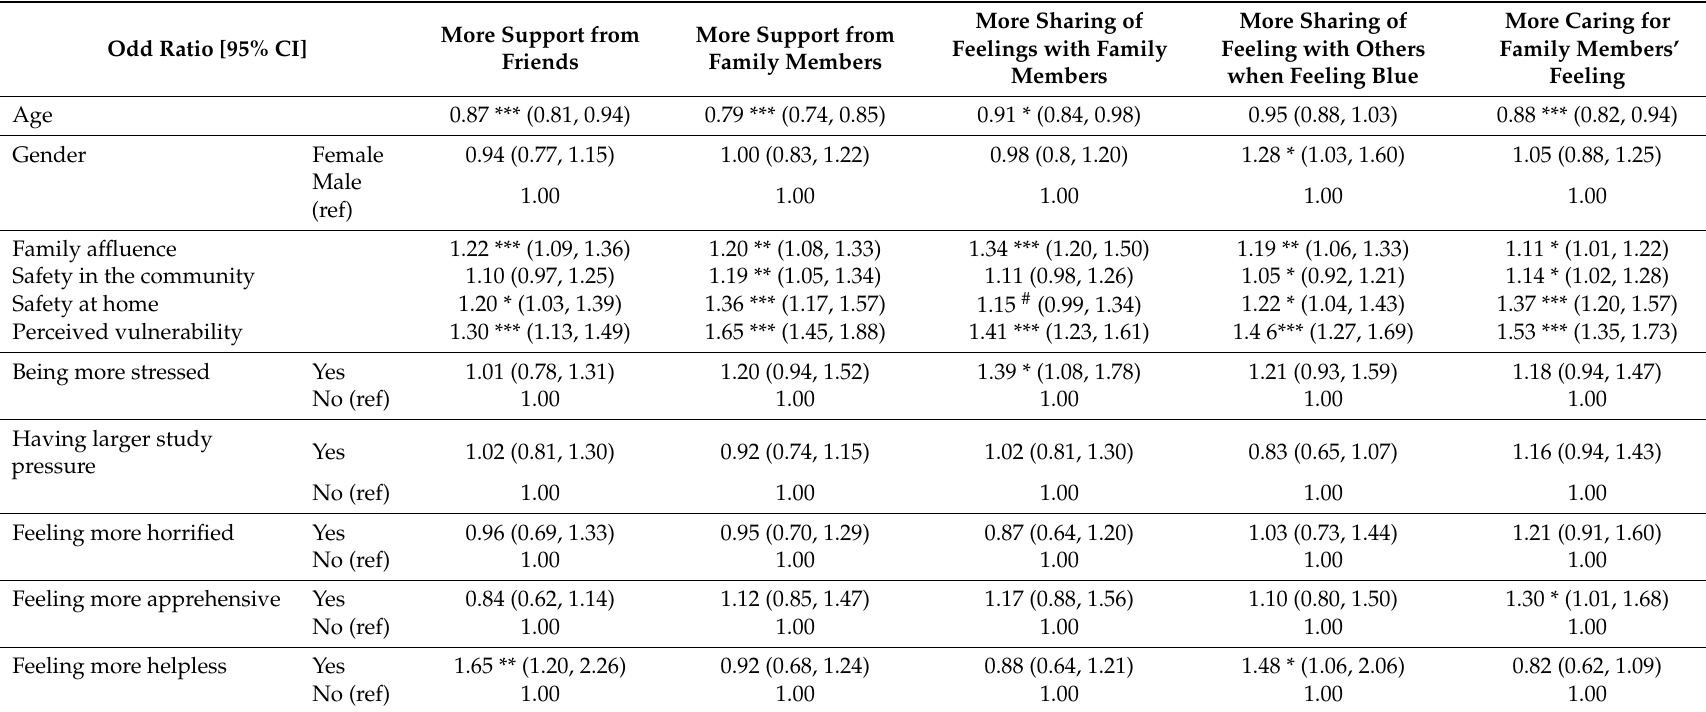
Table 7. Binary logistic regression on the positive changes of social